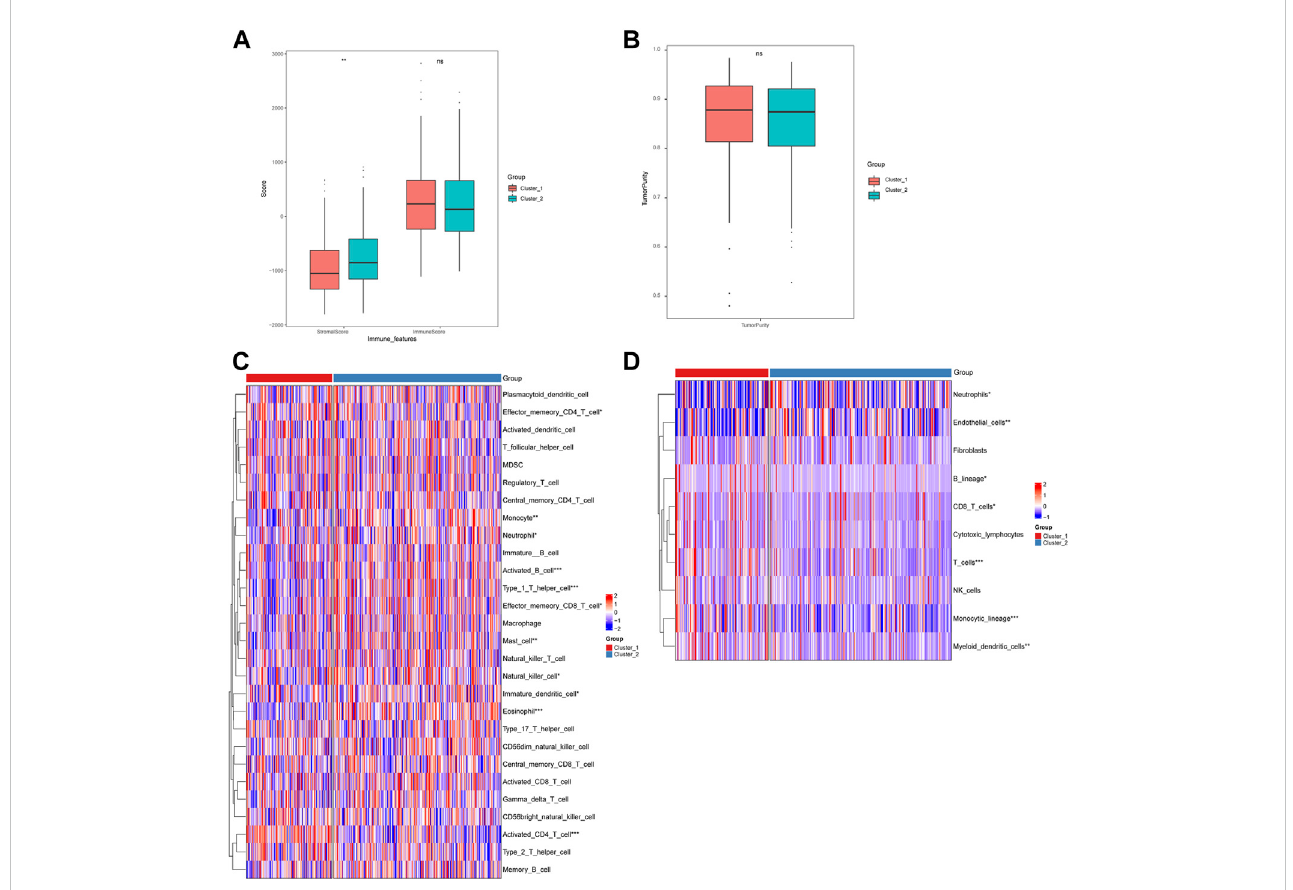
FIGURE 4 Differencesinimmune cellin fi ltration amonghepatocellularcarcinoma subtypes. (A) ESTIMATEalgorithm calculates differences instromaland immune scores between subtypes; (B) ESTIMATE algorithm calculates differences in tumor purity scores between subtypes; (C) GSVA-cell report algorithm calculates differences in immune cell in fi ltration between subtypes; (D) MCP-counter calculates differences in subtypes differences in immune cell in fi ltration (ns: p > 0.05; *: p < 0.05; **: p < 0.01; ***: p < 0.001; ****: p <